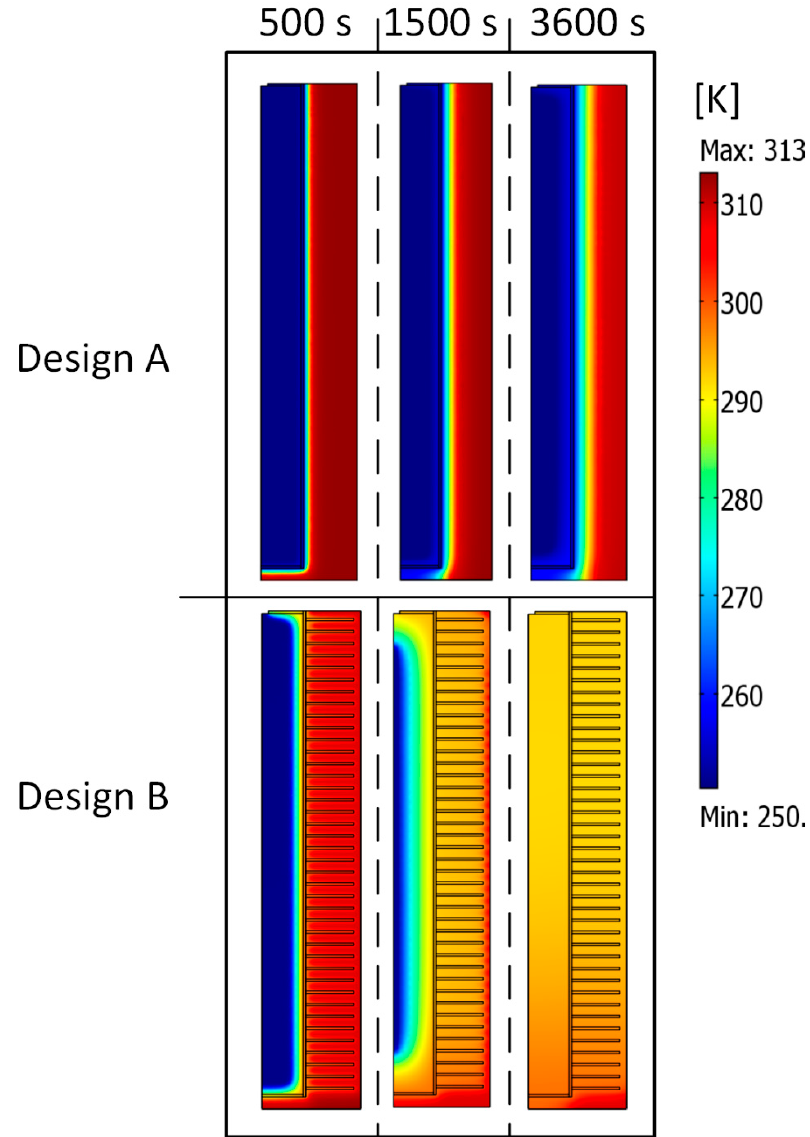
Figure 3. Temperature contours in the two designs at different times.